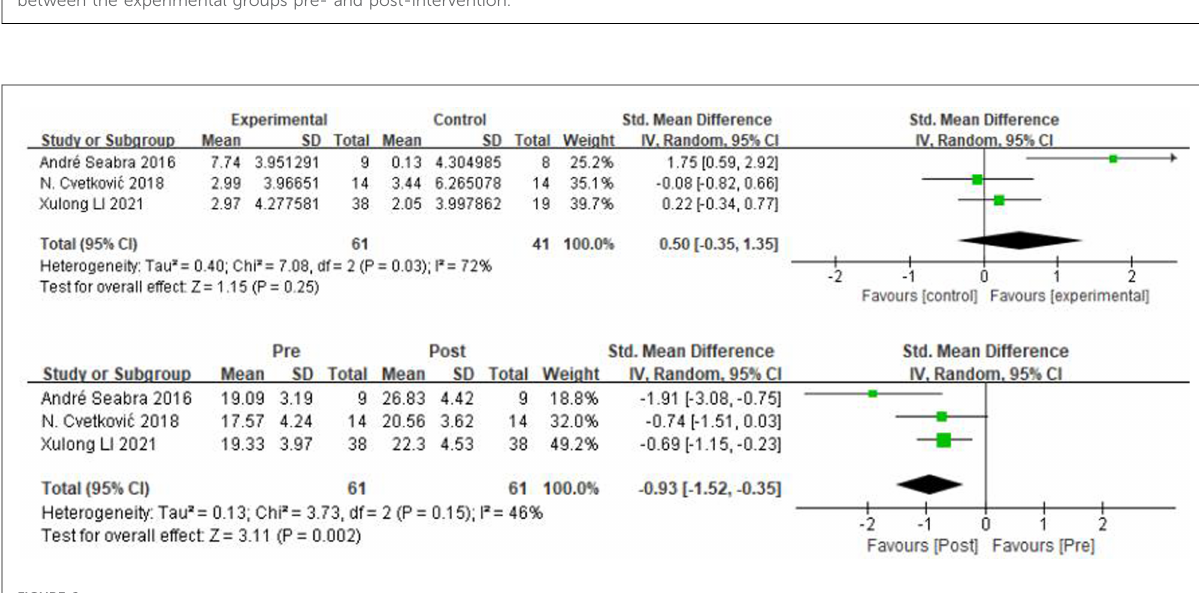
FIGURE 6 A meta-analysis of the results of countermovement jump was conducted for comparisons between the control and experimental groups and for comparisons between the experimental groups pre- and